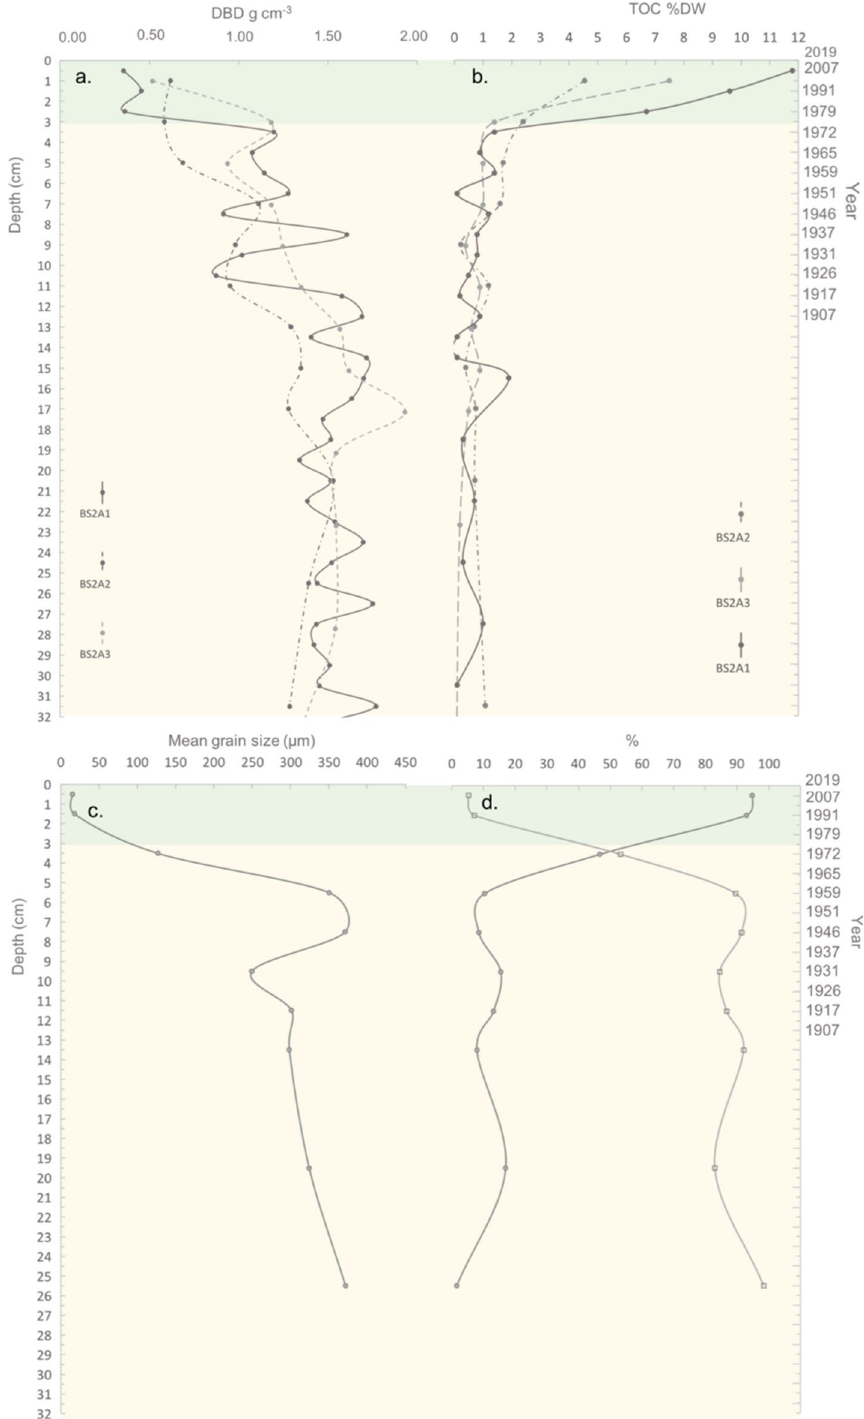
Figure 4. Changes in biogeochemical variables along sediment depth (left axis) and time (right axis): ( a ) dry bulk density and ( b ) sediment organic carbon content measured in the three sediment cores sampled (BS2A1, BS2A2 and BS2A3) and ( c ) mean grain size and ( d ) proportion of sand (•—) and silt & clay (•—) measured in the core BS2A1. Green color indicates the period after the building of the bridge in